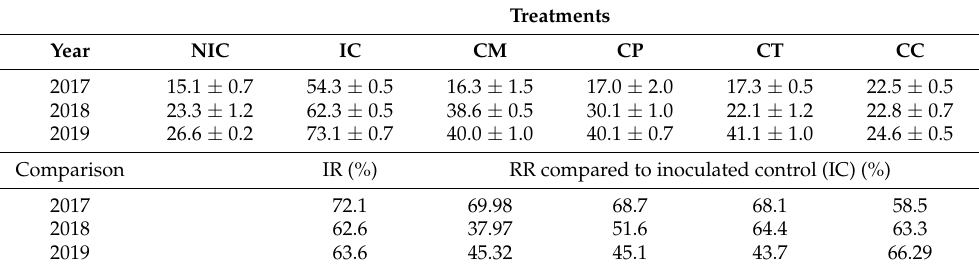
Table 3. Effect of treatments on FHB severity in durum wheat evaluated in a three-year study.